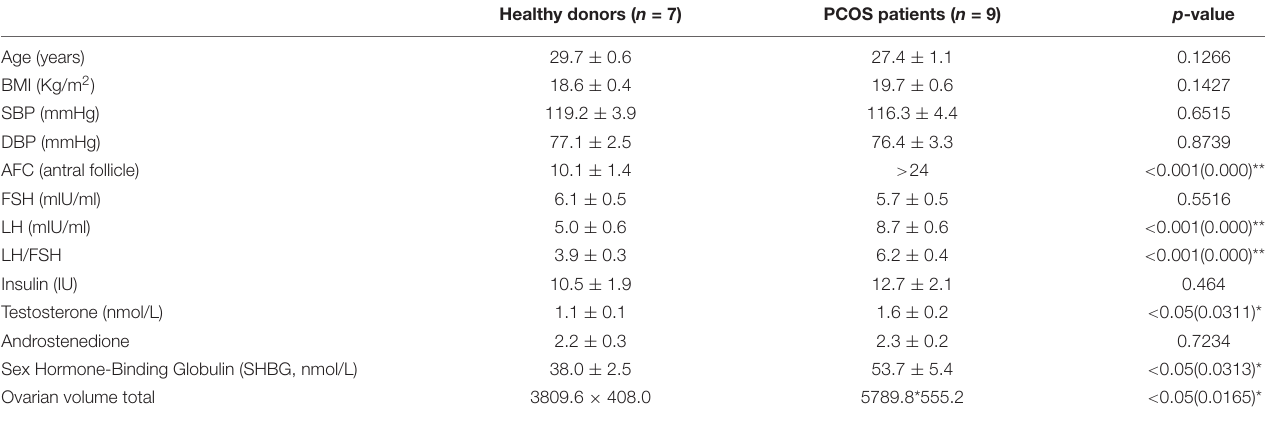
TABLE 1 | The clinical variables of healthy donors and PCSO